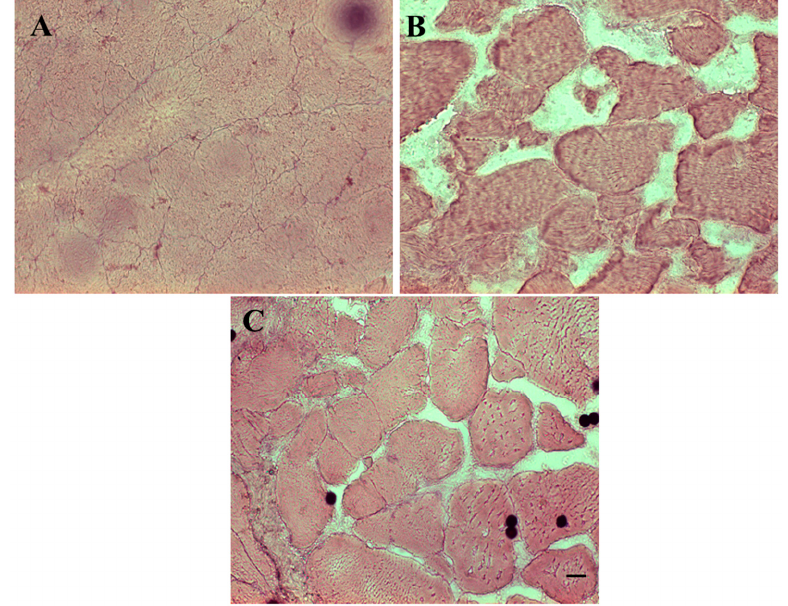
Figure 1. Hematoxylin–eosin staining of transversal sections of trout fillets. ( A ) uncoated trout fillet at the beginning of the experiment (UTF 0 day); ( B ) uncoated fillet after a period of 12 days of storage (UTF 12 days); ( C ) coated fillet after 12 days of storage (CTF 12 days). ACTF gave similar results to CTF. Scale bars: A, B: 40 µ m; C: 20 µ m. Sections are representative of three trout analyzed for each experimental